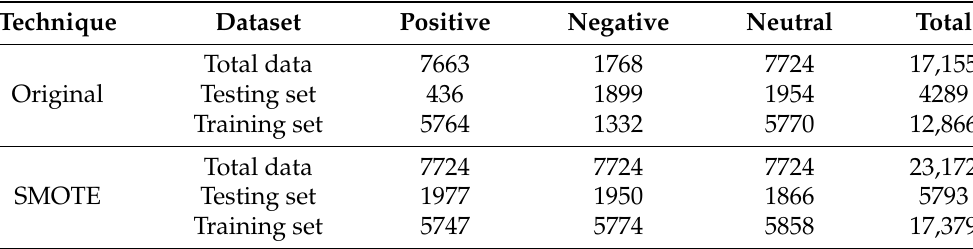
Table 5. Train and test count after data splitting.